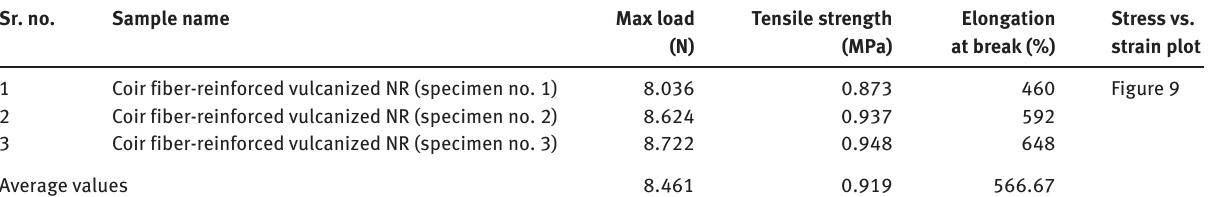
Table 7: Mechanical properties of coir fiber-reinforced vulcanized NR composite after water resistance at ambient temperature for 8 h. Sr.